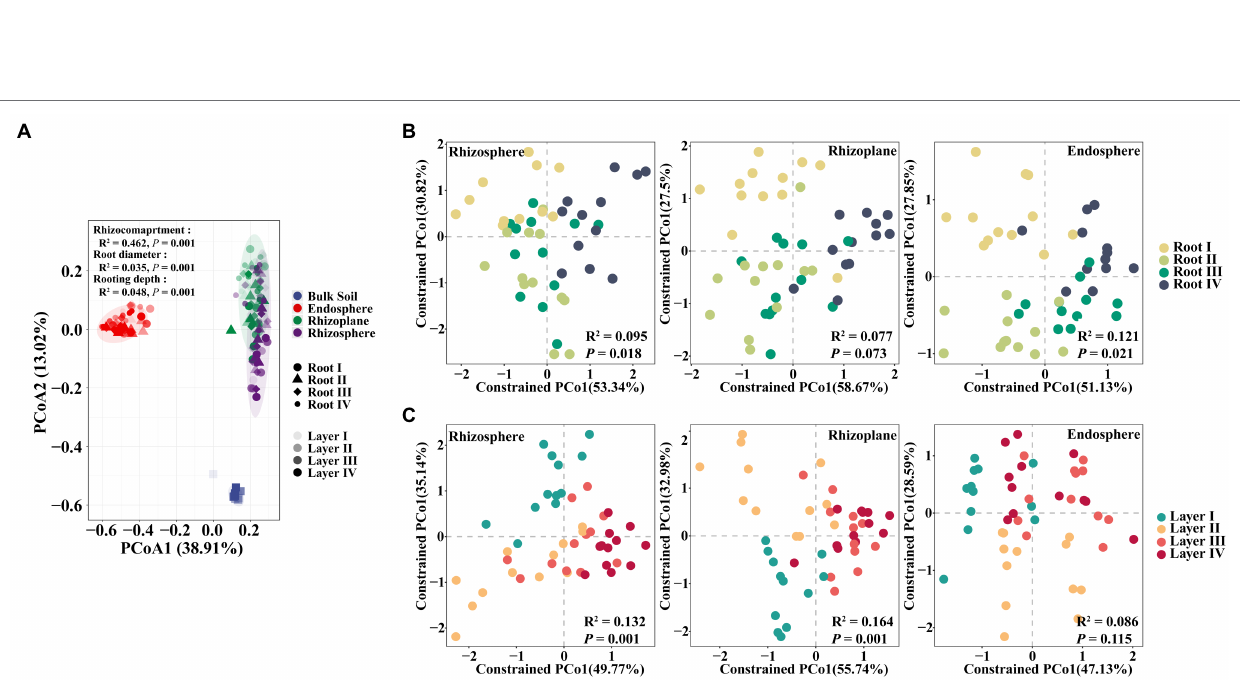
FIGURE 2 | Principal coordinates analysis (PCoA) based on Bray-Curtis distances and constrained analysis of principal coordinates (CAP) based on Bray-Curtis distances of soybean root-associated microbiome. (A) PCoA plot showing differences in the beta diversity of all samples. (B) CAP plot showing bacterial compositional variation in rhizosphere, rhizoplane or endosphere explained by root diameter when controlling for rooting depth. (C) CAP plot showing bacterial compositional variation in rhizosphere, rhizoplane or endosphere explained by rooting depth when controlling for root diameter. Variance values were examined via PERMANOVA test, which are shown in each